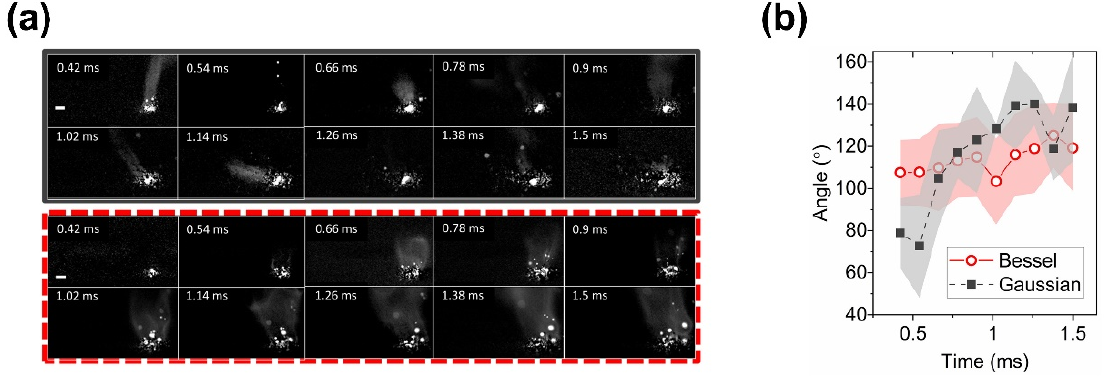
Figure 23. ( a ) Side views of melt pool captured using Gaussian (top, gray border) and Bessel (bottom, dashed red border) lasers; ( b ) angle of melt pool steam relative to horizontal level as a function of time. (Reprinted with permission from Ref. [129]. Copyright 2021 AAAS).